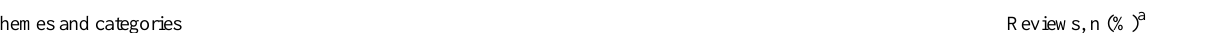
Table 3. Themes and categories emerging from content analysis of Web-based reviews for selected mobile phone medication adherence apps (N=1323 user